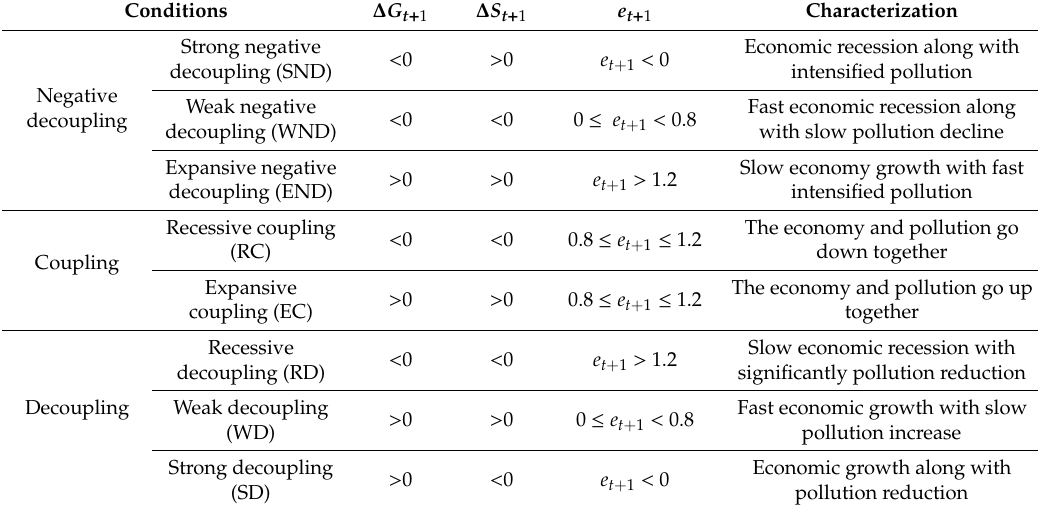
Table 1. Decoupling State